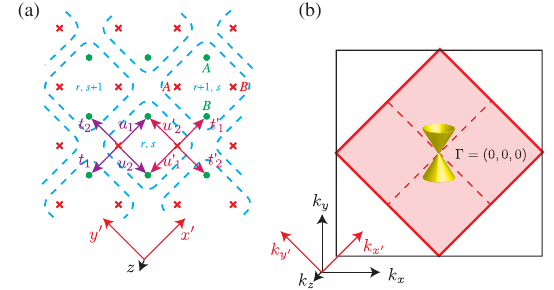
FIG. 9. (a) The massive AFTR and C 2 breaking coupled Dirac wire model. (b) The reduced Brillouin zone (BZ) after translation symmetry breaking where the two Weyl points collapse to a single Dirac point at M